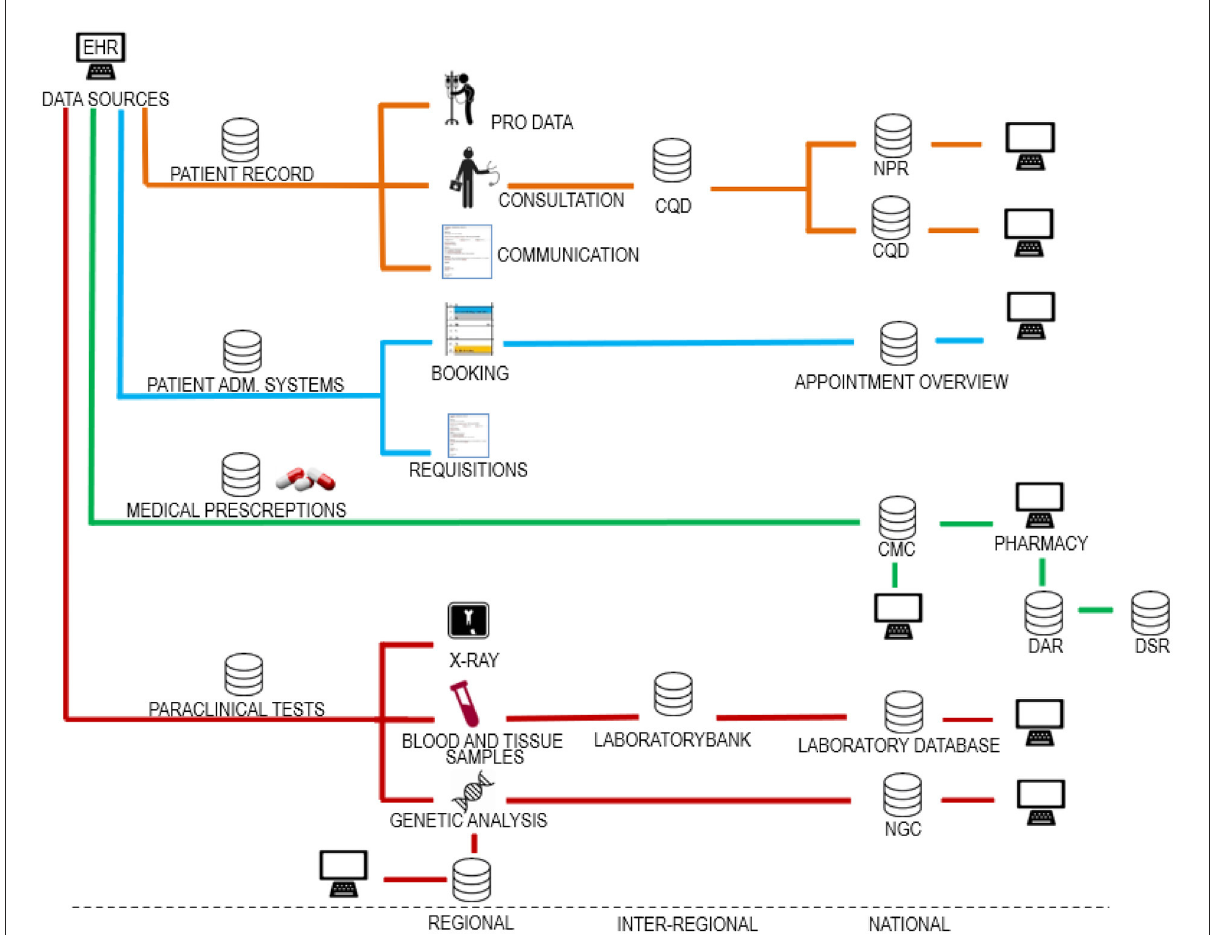
FIGURE1 Danish digital infrastructure for health data. The figure shows different data categories divided into regional, interregional and national systems. Source systems making up the digital infrastructure can be categorized in relation to four data categories. (1) data collected for use in the patient record, (2) data collected for administration of the patient course, (3) data on drugs for use in the administration of drugs, and (4) paraclinical data. As shown, it is a basic principle that the same health data are usually stored both regionally, nationally, and in some cases also inter-regionally. In this way, data control is divided between the regions and the state. This data redundancy may be deliberate but may also be by chance as the infrastructure has grown organically over many years. The figure is included in a textbook by Kristensen (24). EHR,